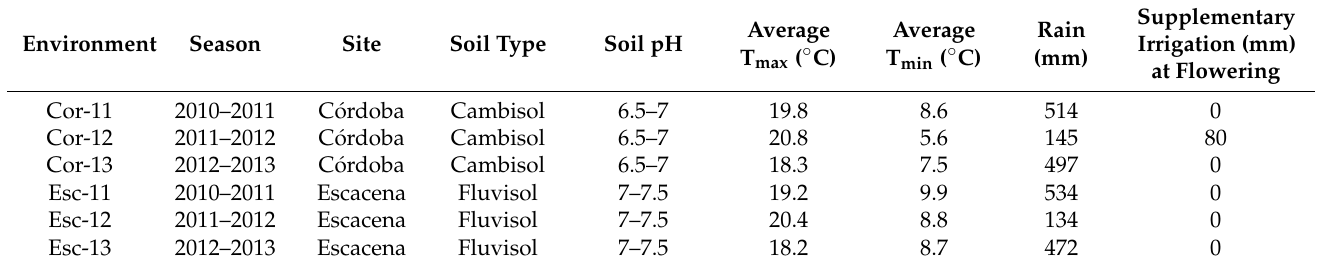
Table 2. Description of the environments of the trials for the multi-environment